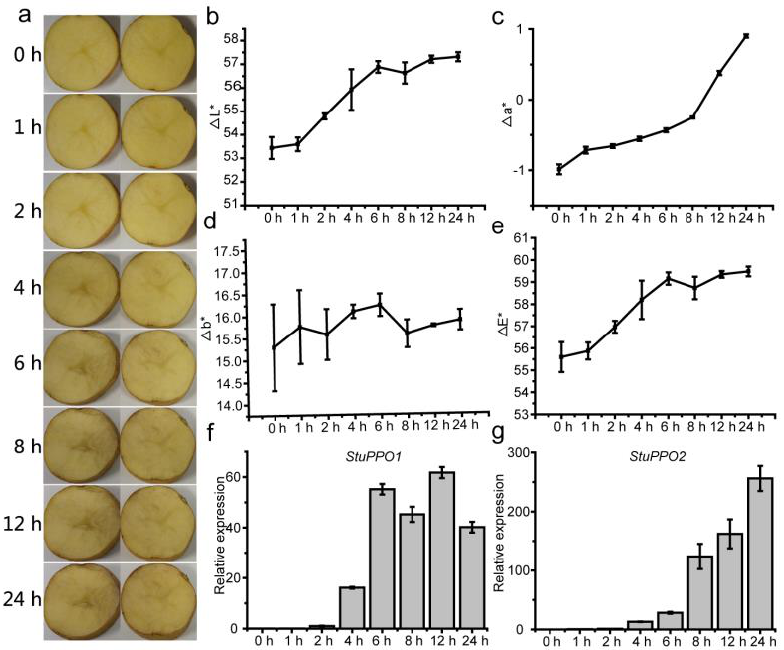
Figure 1. The changes of phenotype and related indexes of potato tuber during enzymatic browning. ( a ), Browning characteristic of potato tubers at different times; ( b – e ), the changes of ∆ L*, ∆ a*, ∆ b*, and ∆ E* of potato tubers during enzymatic browning, respectively; ( f , g ), The expression of PPO genes at different times in potato tubers after cutting. Values are means ± SE (n = 3).